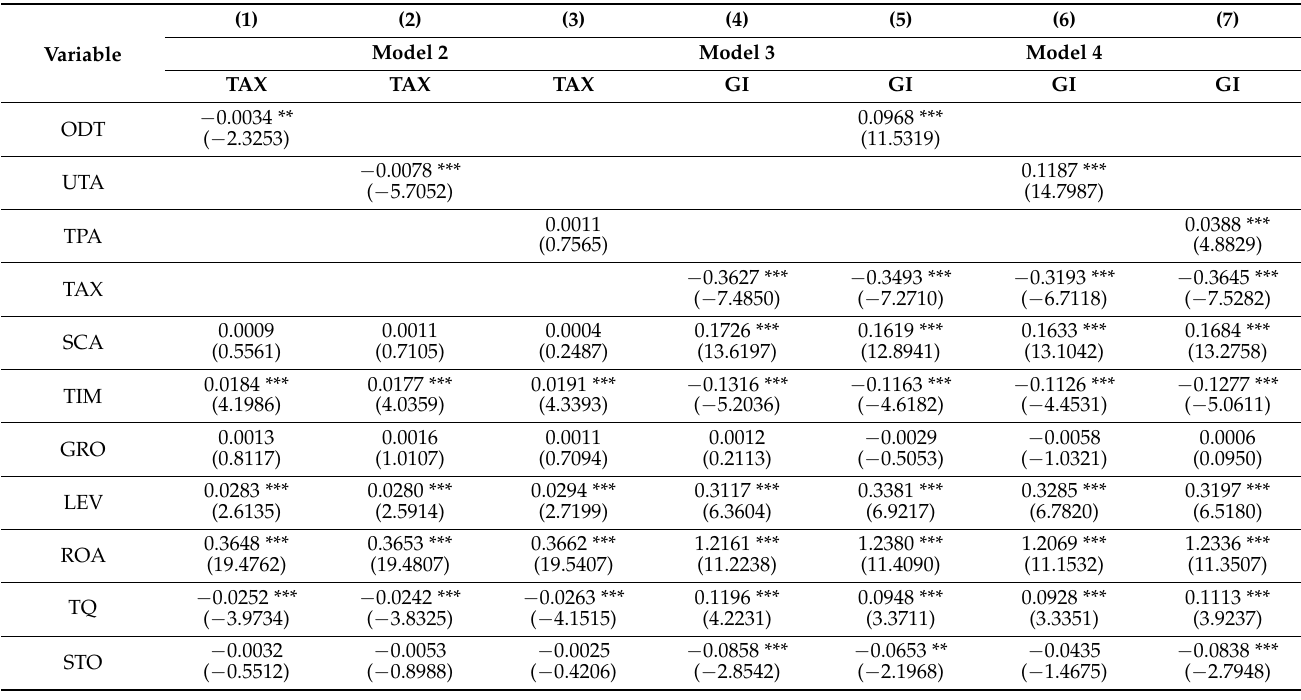
Table 6. Test results of transmission mechanism of income tax